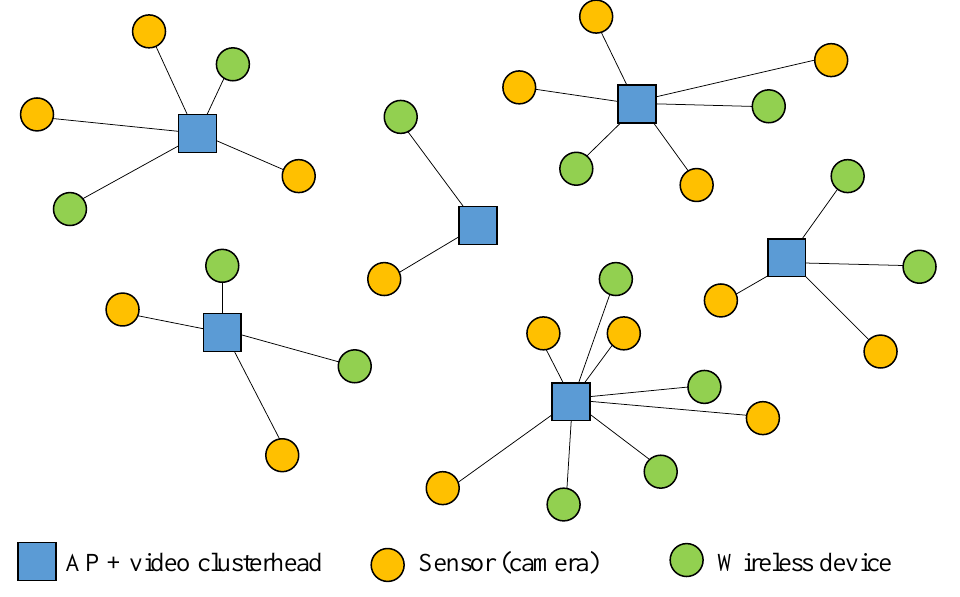
Figure 1. Wireless surveillance sensor network (WSSN)